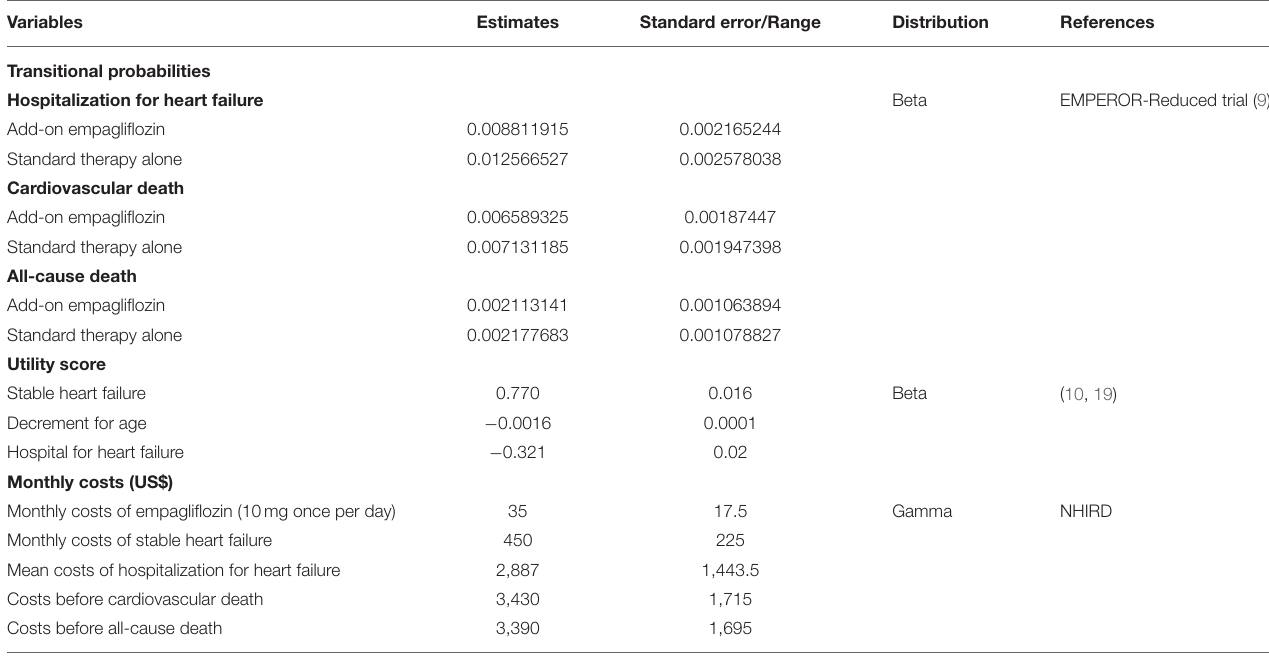
TABLE 1 | Input parameters for base-case analysis in the model in Taiwan setting.